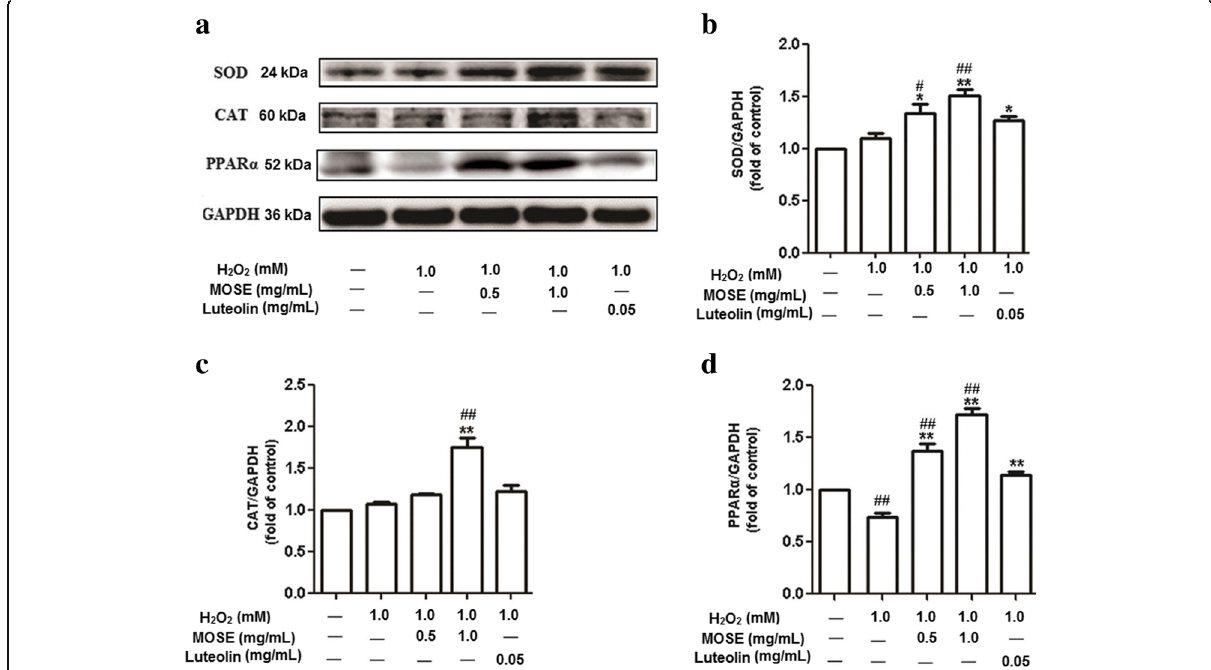
Fig. 4 Effects of MOSE and luteolin on expressions of SOD, CAT and PPAR α . Lenses were pretreated with MOSE (0.5 and 1.0 mg/mL) or luteolin (0.05 mg/ mL) for 24 h, followed by incubation with H 2 O 2 (1 mM) for another 24 h, and then recovered in fresh medium for 48 h. Then, protein expressions were determined by western blot ( a ). Quantification of western blot for SOD ( b ), CAT ( c ), and PPAR α ( d ). Data are expressed as the mean ± SEM ( n = 3); # P < 0.05 and ## P < 0.01, compared with the normal control group; *P < 0.05 and **P < 0.01, compared with the H 2 O